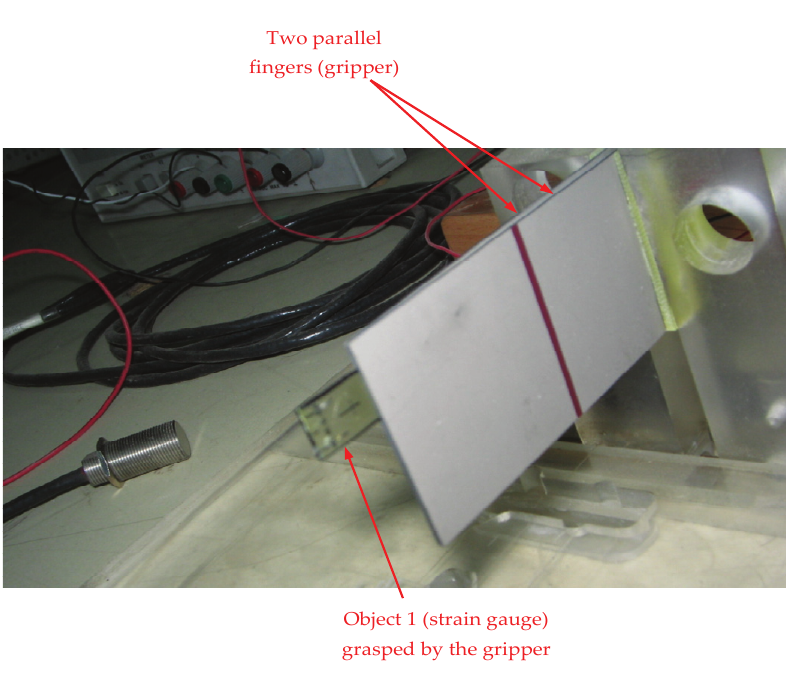
Figure 8. The micro-gripper grasps small object 1 (strain gauge).